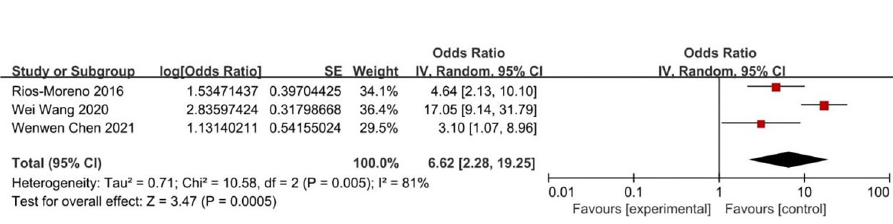
Fig 3. Forest diagram of the relationship between birth weight < 1000g and the incidence of MBDP.